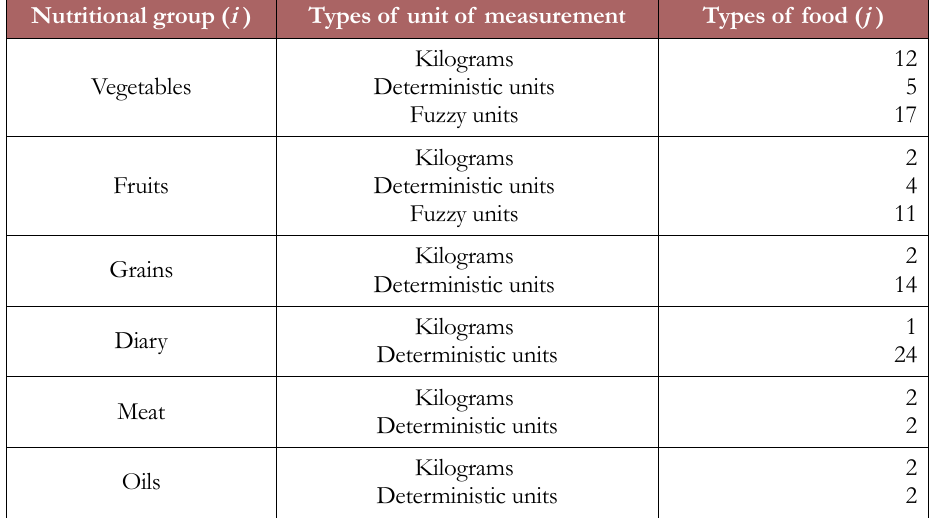
Table 1. Types of food considered in